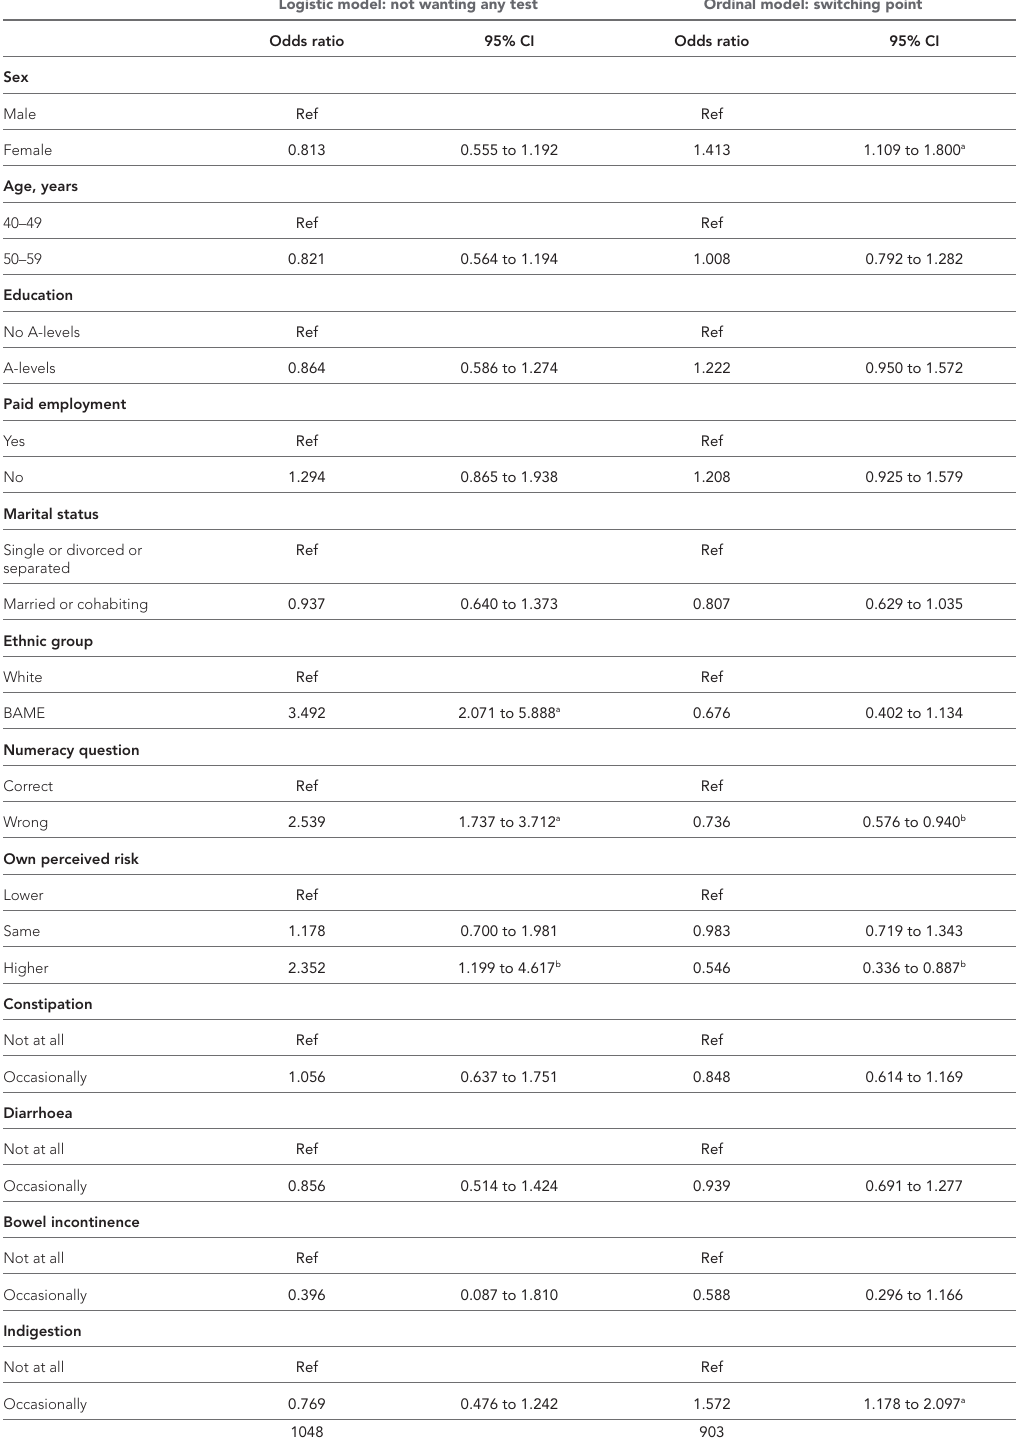
Table 2 Multivariate models explaining not wanting to have CC or FIT and switching point Logistic model: not wanting any test Ordinal model: switching point Odds